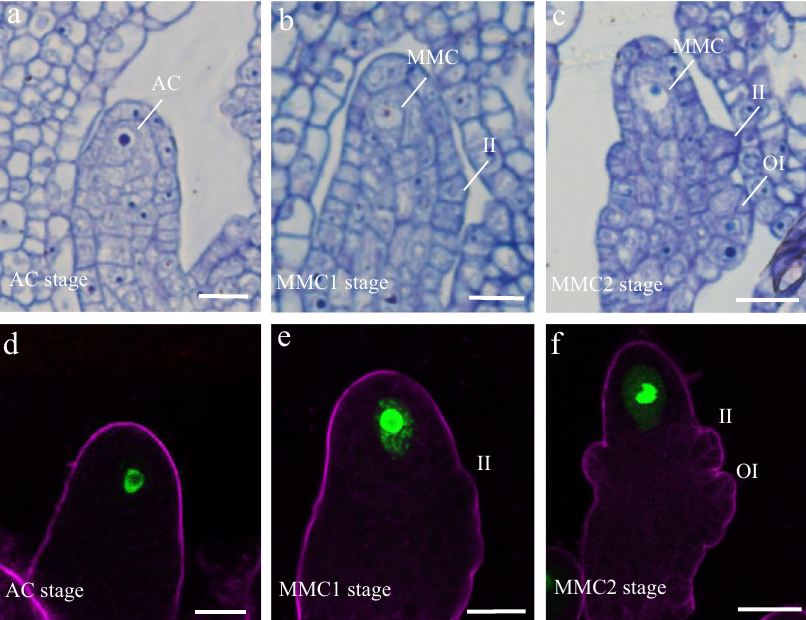
Fig. 1 Ovule primordia structure at the AC, MMC1, and MMC2 stages. a – c Resin semi-thin sectioning of ovule primordia at the archesporial cell (AC; a ) and megaspore mother cell stage 1 (MMC1; b ) and MMC2 ( c ) stage. d – f pKNU:KNU-Venus expression patterns in ovule primordia at the AC ( d ), MMC1 ( e ), and MMC2 ( f ) stages. The magenta signal corresponds to FM4-64 dye outlining the ovule. II inner integument, OI outer integument. Scale bars, 10 μ